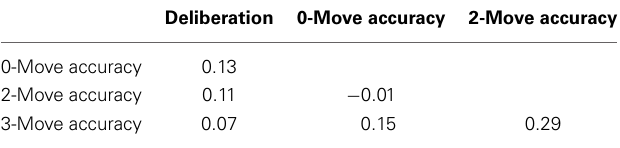
Table 3 | Spearman’s rho correlations between impulsive personality traits and accuracy on the Scarborough adaptation of the Tower of London.